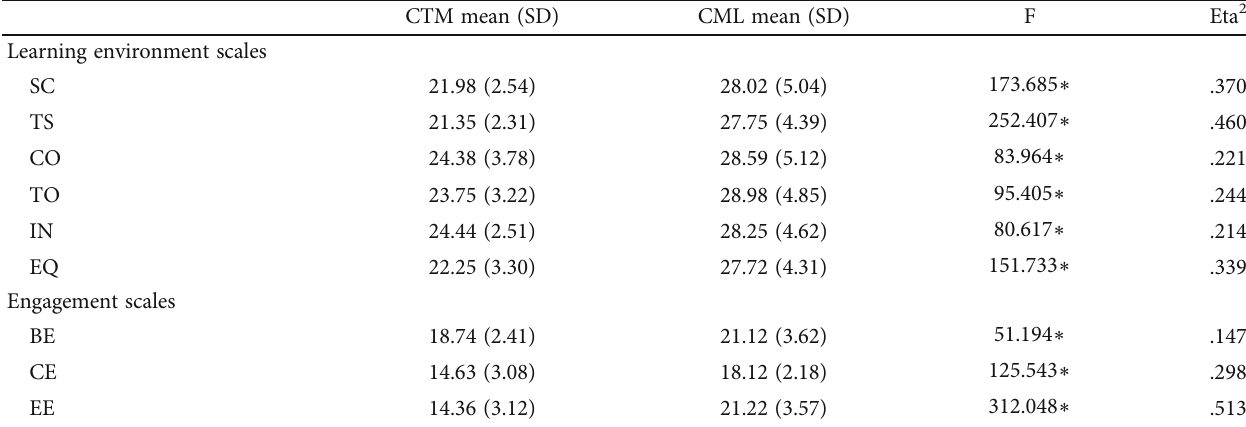
Table 3: Mean, standard deviation, and di ff erences for students in CML and CTM for WIHIC and SEQ